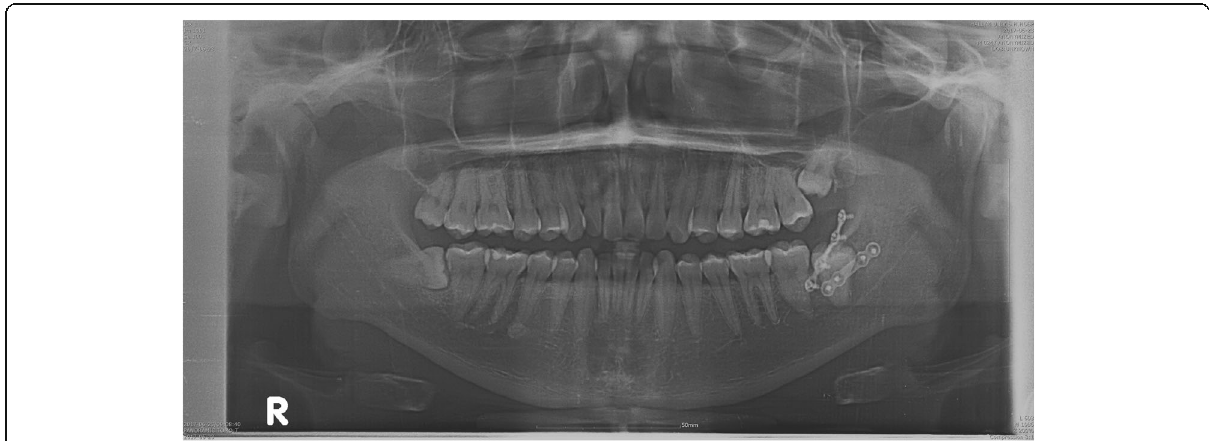
Fig. 4 Postoperative panoramic radiographs treated with conventional plate